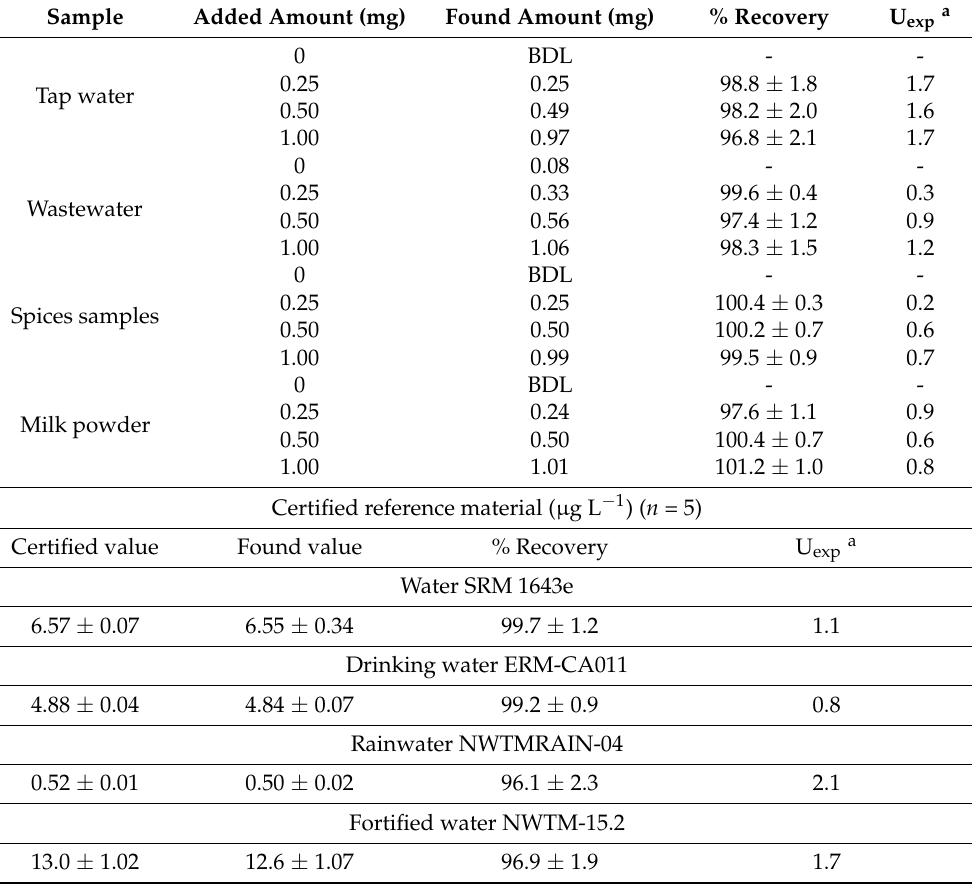
Table 6. Validation of designed experiment through standard addition method ( n =